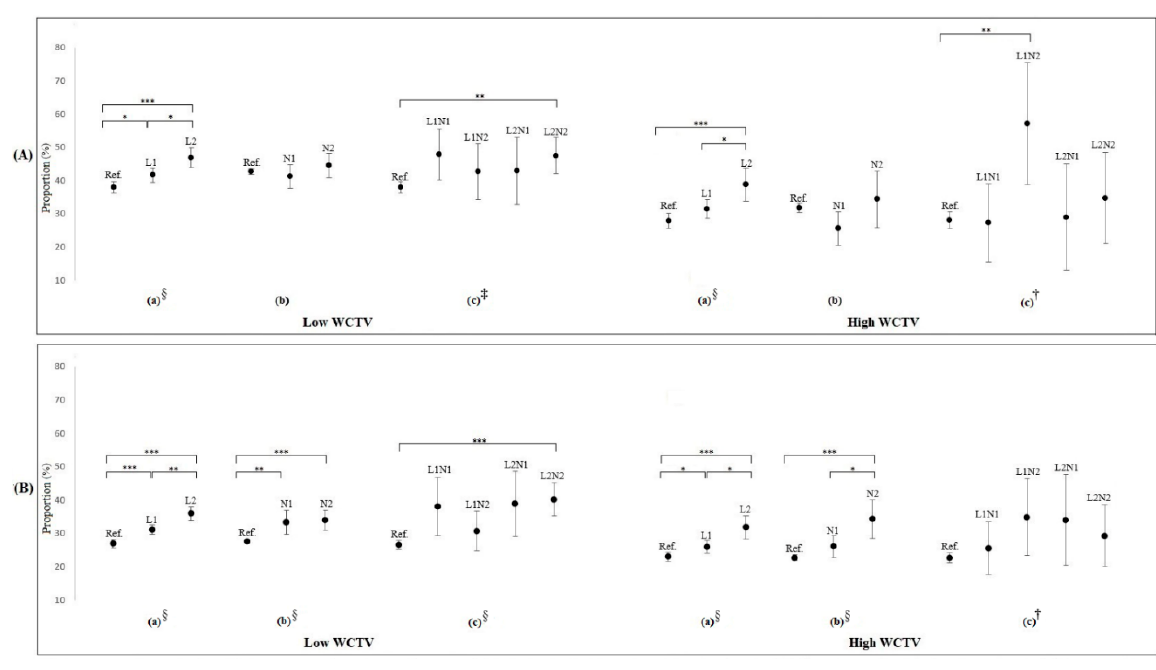
Figure 1. Proportions of those with low subjective well-being according to long working hours and night work, subdivided by work creativity and task variety (WCTV) and occupation ( A ) blue collar workers, ( B ) white collar workers). Note: L1 indicates 52–60 h per week, L2 indicates >60 h per week, N1 indicates night work for 1–10 days per month, and N2 indicates night work for >10 days per month (* p < 0.05, ** p < 0.01, *** p < 0.001 for pairwise comparison and † p < 0.05, ‡ p < 0.01, § p < 0.001 for chi-square